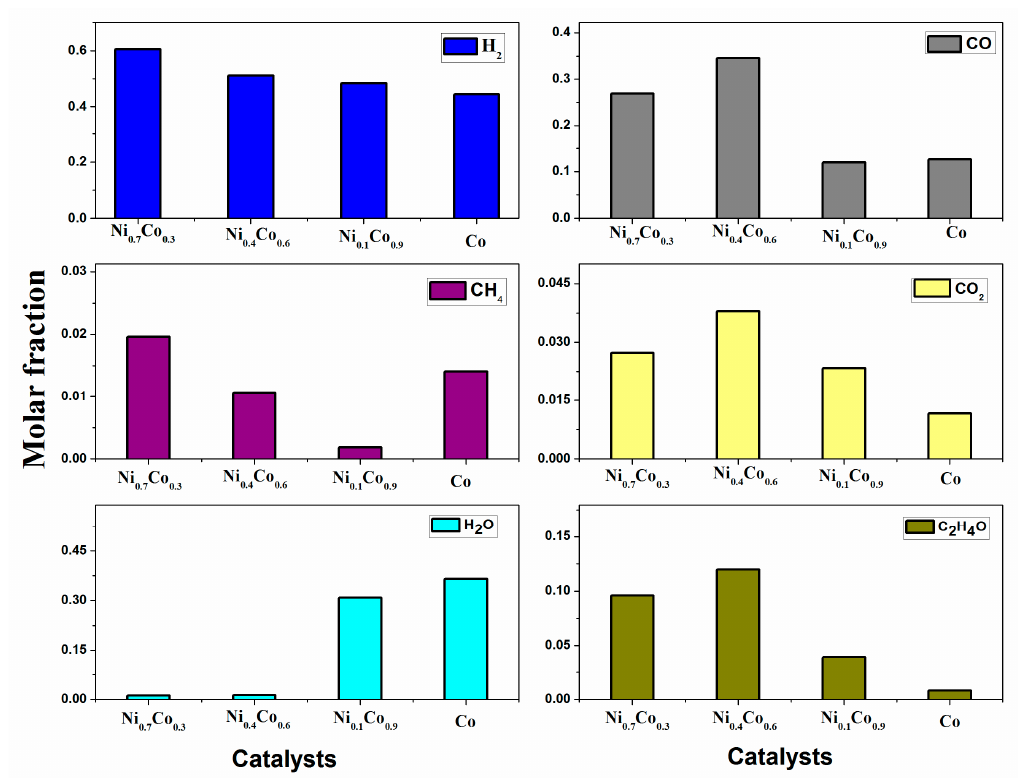
Figure 13. Product distribution in ethanol decomposition on Ni x Co 1-x / La 0.8 Ce 0.2 catalysts at 1 h of reaction at 973 K. Table 3. Carbon deposition on Ni x Co 1-x / La 0.8 Ce 0.2 catalysts evaluated by